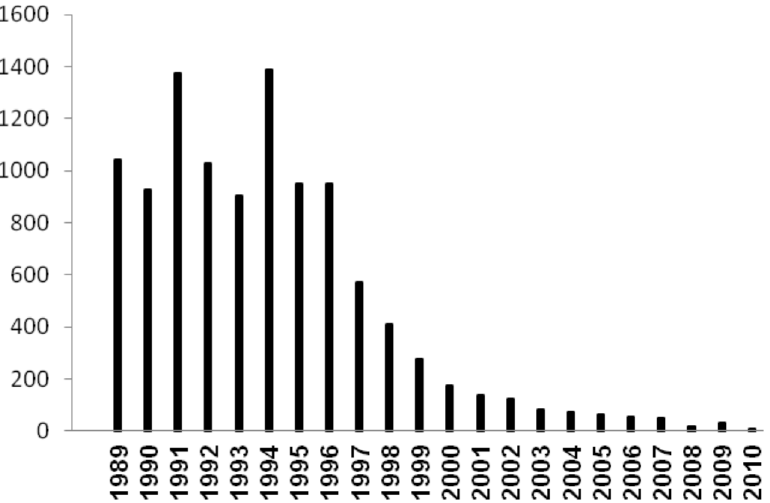
Figure 4. Number of new clinical cases of onchocerciasis in the Southern Chiapas focus, Me´xico. The number of new clinical cases of onchocerciasis (individuals diagnosed positive to Mazzotti reaction, nodules, or skin mf for the first time) in the Southern Chiapas focus, from 1989 to 2010.